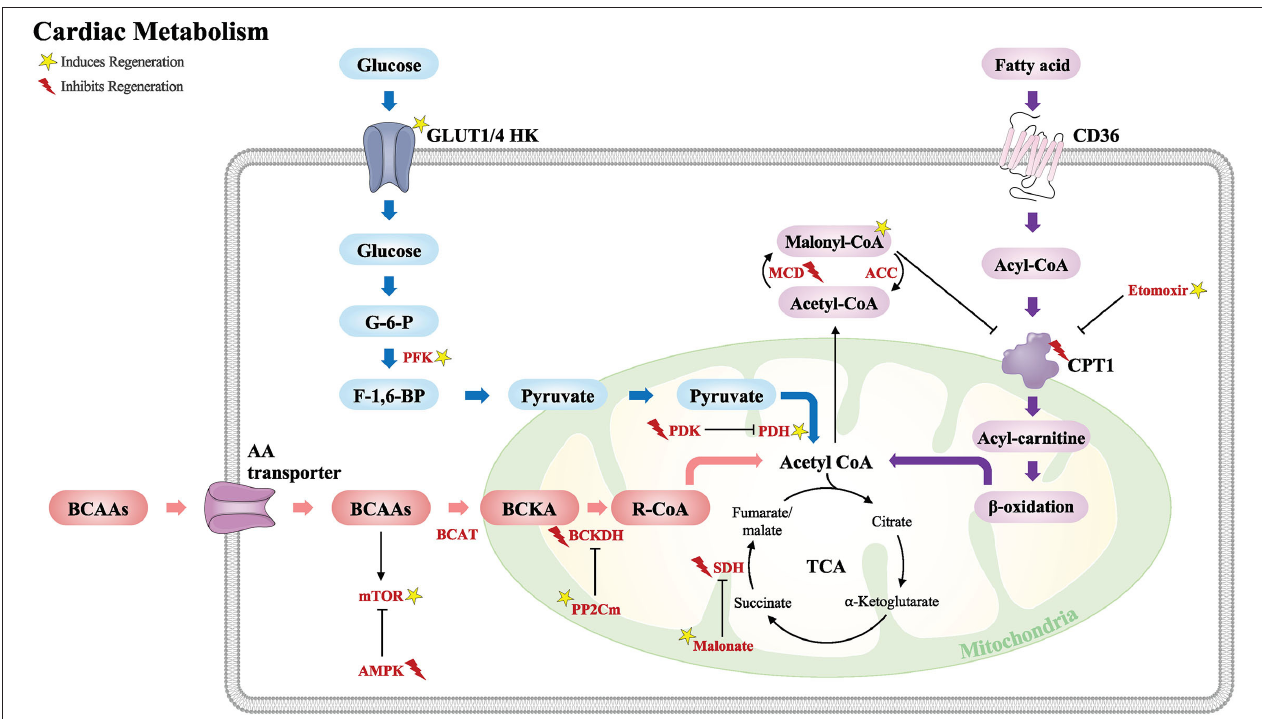
FIGURE 2 | Schematic of the major metabolic pathways that modulate the cardiac regenerative response following injury. Glucose metabolism (blue), fatty acid metabolism (purple), and BCAA metabolism (red). Acetyl CoA from these major metabolic pathways is required for the TCA cycle. GLUT, glucose transporter type; HK, hexokinase; G-6-P, glucose-6-phosphate; F-1,6-BP, fructose-1,6-biphosphate; PFK, phosphofructokinase; PDK, pyruvate dehydrogenase kinase; PDH, pyruvate dehydrogenase; CD36, cluster of differentiation; CPT1, carnitine palmitoyltransferase; MCD, malonyl CoA dehydrogenase; ACC, acetyl CoA carboxylase; BCAAs, branched-chain amino acids; AA, amino acid; BCAT, branched-chain amino-transferase; BCKA, branched-chain alpha keto acids; BCKDH, branched-chain alpha-keto acid dehydrogenase; PP2Cm, protein phosphatase 2Cm; mTOR, the mechanistic target of rapamycin; AMPK, 5 ′ adenosine monophosphate-activated protein kinase; TCA, tricarboxylic acid cycle; SDH, succinate dehydrogenase. Yellow star induces regeneration and red lightning bolt inhibits